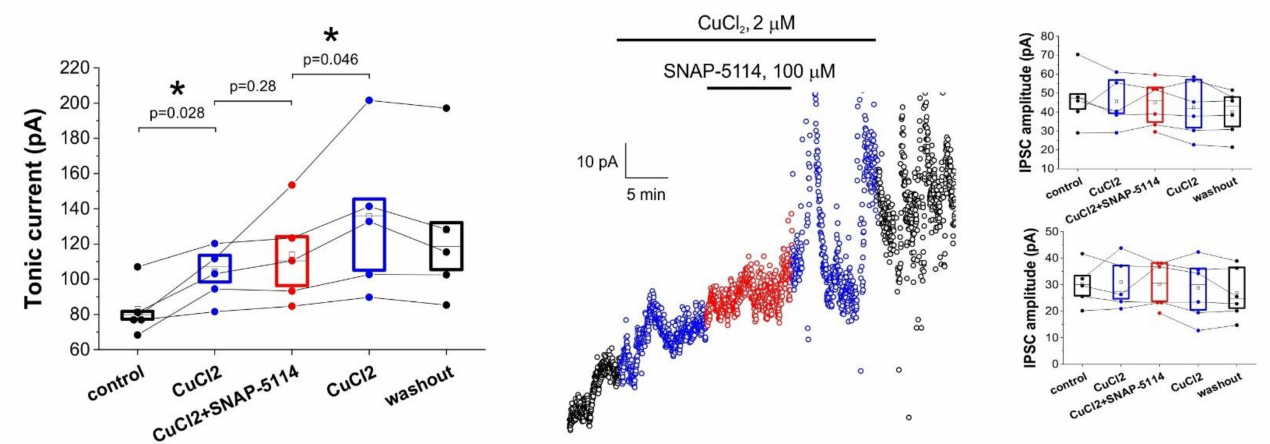
Figure 3. Added CuCl 2 induces tonic inhibition which can be reduced by blocking glial GABA transporters in low-[Mg 2+ ] ACSF. Left: Box-chart representation of GABA ergic baselines during control condition, CuCl 2 application, addition of SNAP-5114 and washout. Box edges represent 25th, 50th and 75th percentile, open squares represent means, circles connected by lines represent paired individual baseline values. (N = 5). Middle: baseline currents plotted at 1 s intervals in a selected experiment. Large fluctuations in baseline current after SNAP-5114 washout correspond to seizure-like events. Right : amplitude and frequency of inhibitory postsynaptic currents (IPSCs). Box edges represent 25th, 50th and 75th percentile, open squares represent means, circles connected by lines represent paired individual baseline values. (N = 5). Neither amplitude, nor frequency changed significantly due to SNAP-5114 application ( p = 0.81 and p = 0.82, respectively). Black symbols represent control and washout periods, blue symbols represent CuCl 2 application, red symbols represent simultaneous SNAP-5114 and CuCl 2 application in all